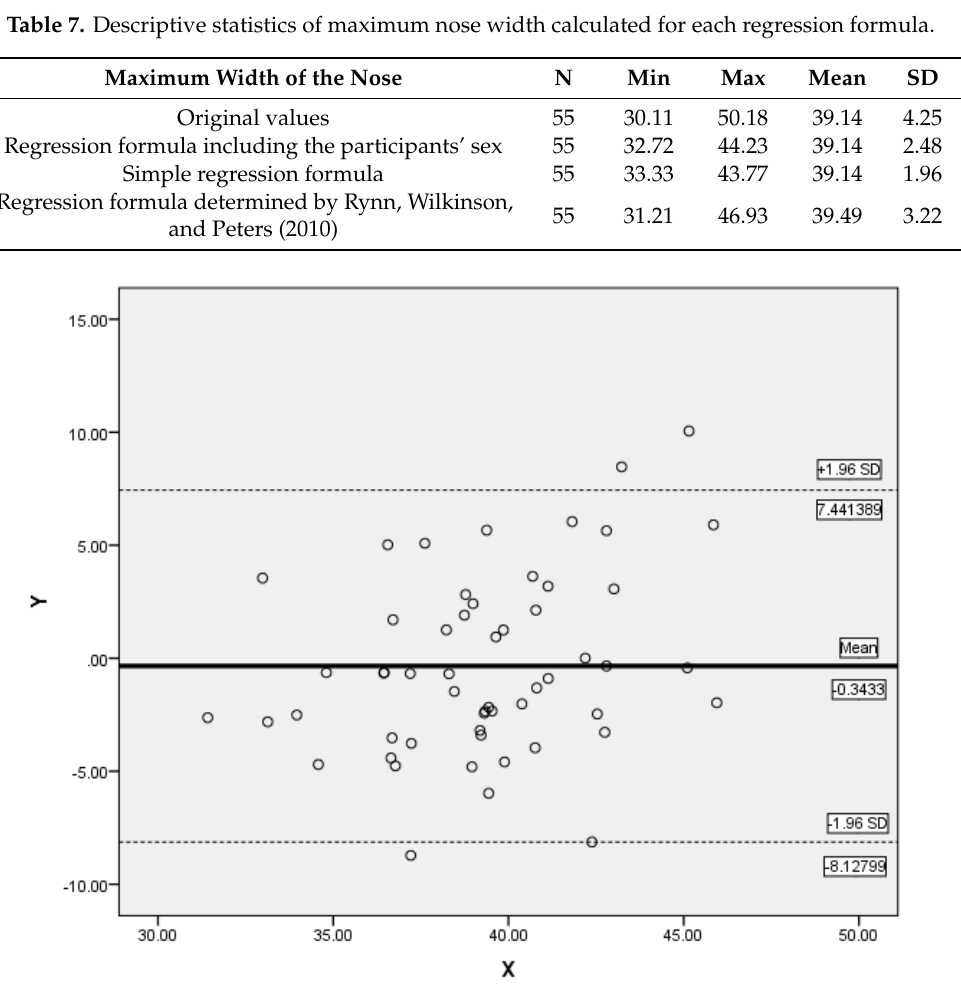
0102030405060 Figure 6. Differences between the real values of the maximum nose width and the predicted nose width following the Rynn and Wilkinson formula.